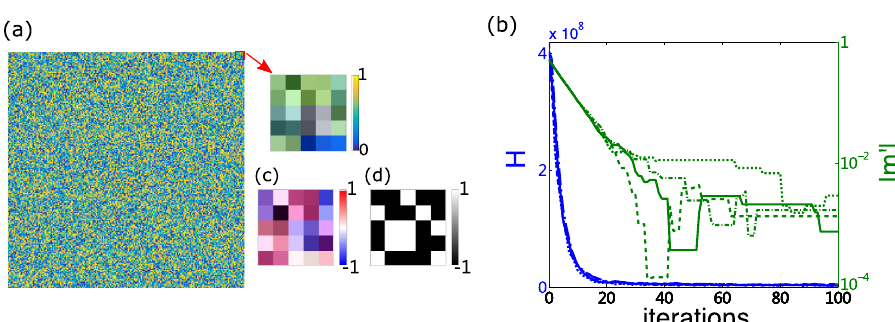
Fig. 3 Experimental results for the searching process of number-partitioning problem. a The set Ξ = { ξ j } containing 40,000 elements, where each ξ j is chosen randomly from (0, 1] with uniform probability. b Evolutions of the Hamiltonian H and the amplitude of the gauge-transformed magnetization m 0 during the iterations. Four independent trials are conducted with uniform initial spin con fi gurations. For clear visualization, c and d , respectively, presents only a part of the fi nal con fi gurations of the gauge-transformed spins f σ 0 z the red square box in ( a ).